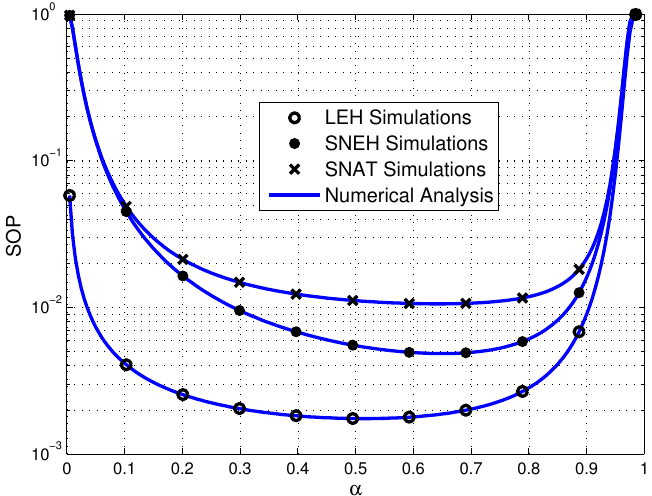
Figure 9. Secrecy outage probability versus α in three EH modes, where τ = 20 dB.